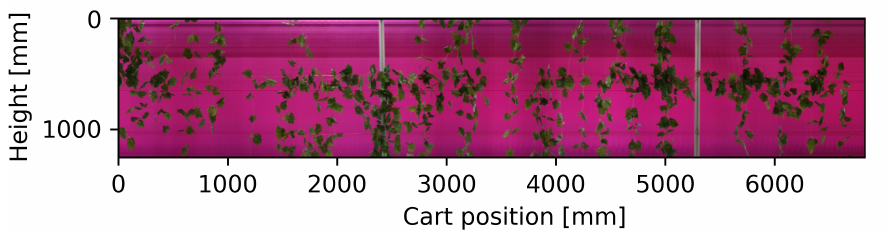
Figure 1. Panoramic image of the synthetic vineyard with purple background for automatic segmen- tation of the ground truth.